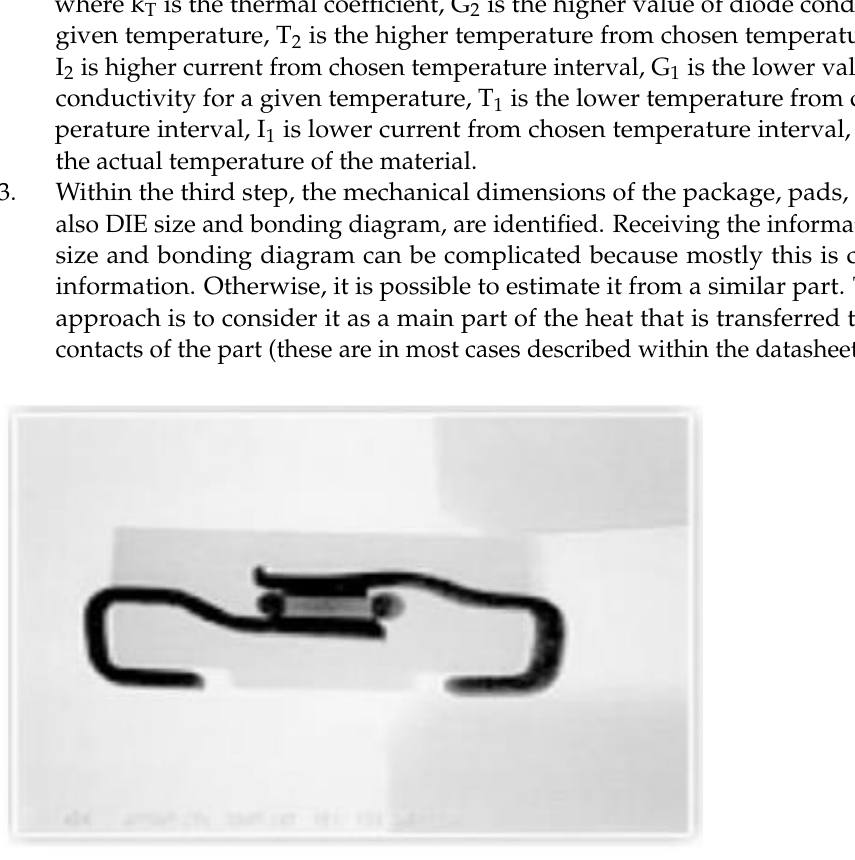
Figure 3. X-ray of semiconductor diode in SMA Package for the DIE size estimation.